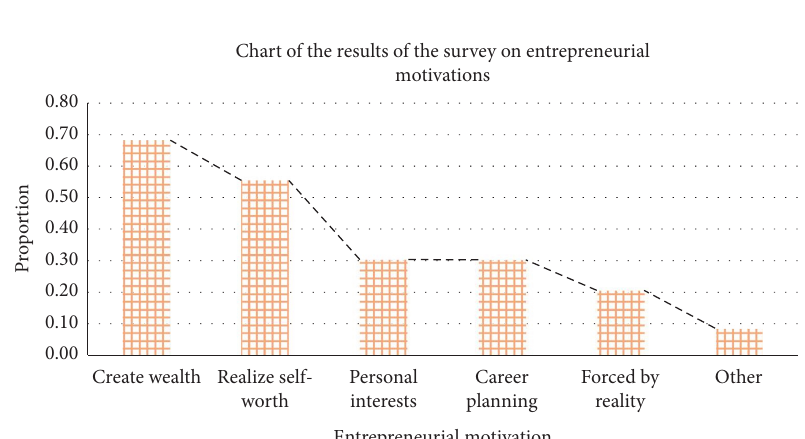
Figure 8: QS results of talent cultivation ability.